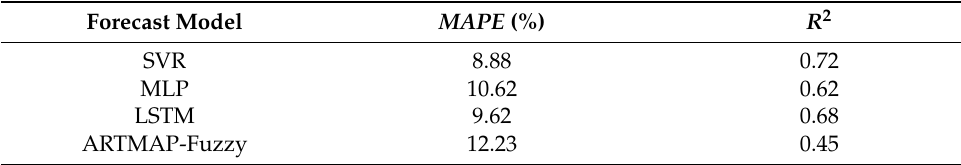
Table 11. MAPE and R 2 for 30-min horizon forecasts.